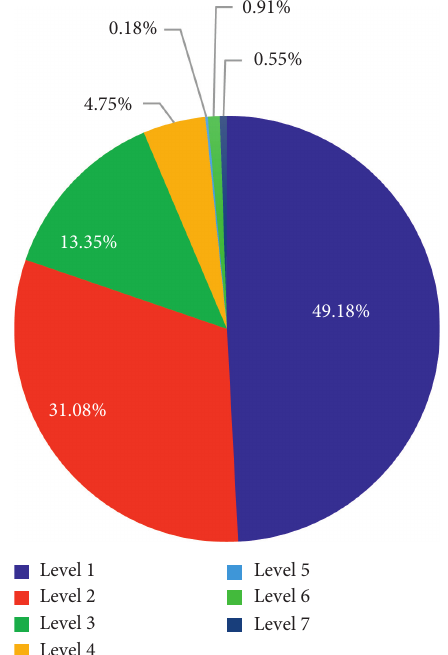
Figure 7: The levels distribution of punishment for anti-rumor accounts (level 1: minus 2 points; level 2: minus 5 points, no posting for 7 days; level 3: minus 10 points, no posting for 15 days; level 4: minus 20 points, no posting for 30 days; level 5: minus 20 points, no posting for 90 days; level 6: no posting forever; level 7: delete account).